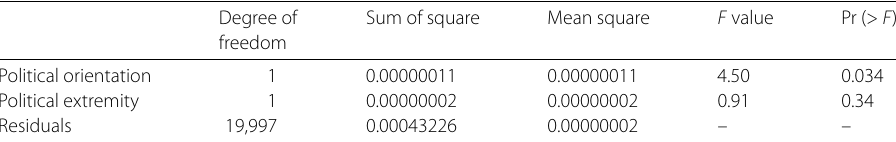
Table 14 ANOVA results to test for correlation of political orientation and extremity with text-based indicators of harm avoidance Degree of Sum of square Mean square F value Pr (> F ) freedom Political orientation 1 0.00000011 0.00000011 4.50 0.034 Political extremity 1 0.00000002 0.00000002 0.91 0.34 Residuals 19,997 0.00043226